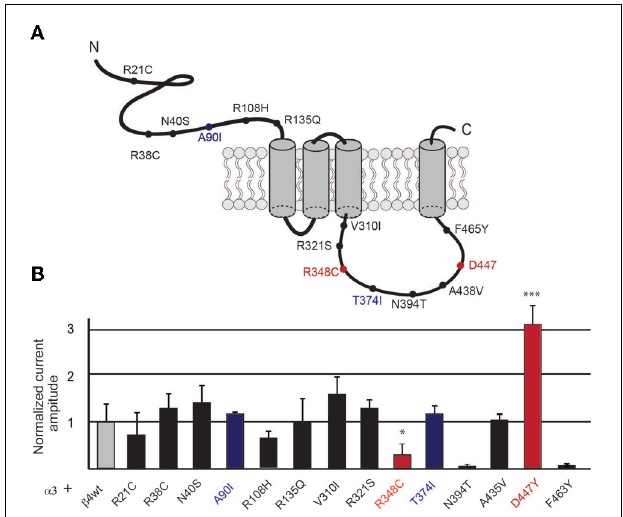
FIGURE 1 | Selected β 4 missense variants and nicotine-evoked currents in oocytes. (A) Graphic representation of the β 4nAChR subunit indicating the location of the rare missense variants at the extracellular and intracellular loops of the receptor subunit. (B) Electrophysiological macroscopic recordings in Xenopus laevis oocytes injected with equal amounts of the wild type transcripts for α 3 and β 4 (1ng α 3 + 1ng β 4) or with equal amounts of transcripts for wild type α 3 and each of the indicated β 4 variants ( n = 10 oocytes per condition). The residues in blue indicate the mouse variants corresponding to the two human β 4 SNPs shown to have increased nicotine currents. Red indicates two additional residues that significantly differ from the wild type β 4nAChR subunit in gray. All values are expressed as mean ± s.e.m. One-way ANOVA F ( 14 , 91 ) = 9 . 1, p < 0 . 0001; Dunnett’s Multiple Comparison post-hoc ∗ p < 0 . 05, ∗∗∗ p < 0 .